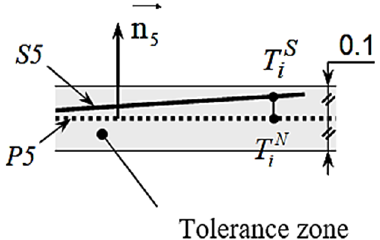
Figure 8. The deviation between the toleranced surface and the nominal part.